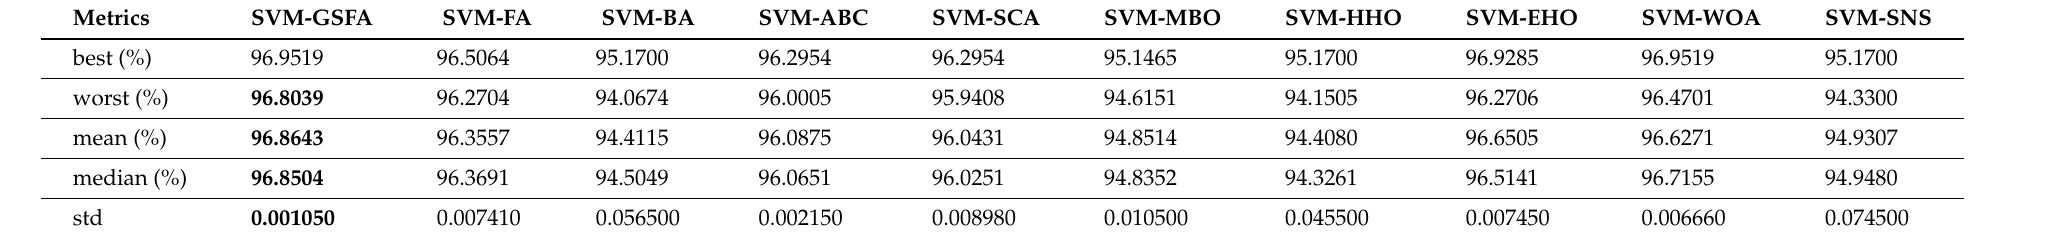
Table 5. SVM Credit Card Fraud small with the SMOTE—general metrics.